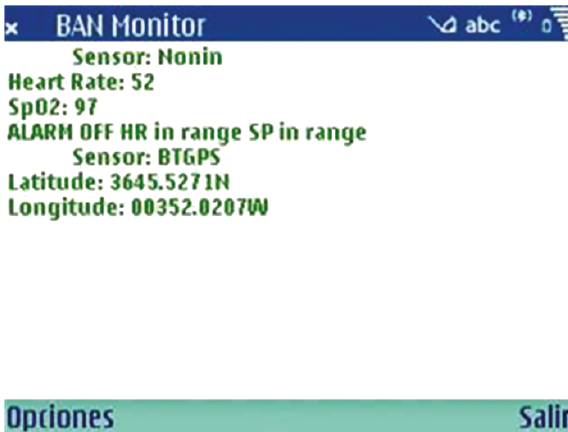
Figure 2: View of the Python application developed for NC (node of control)